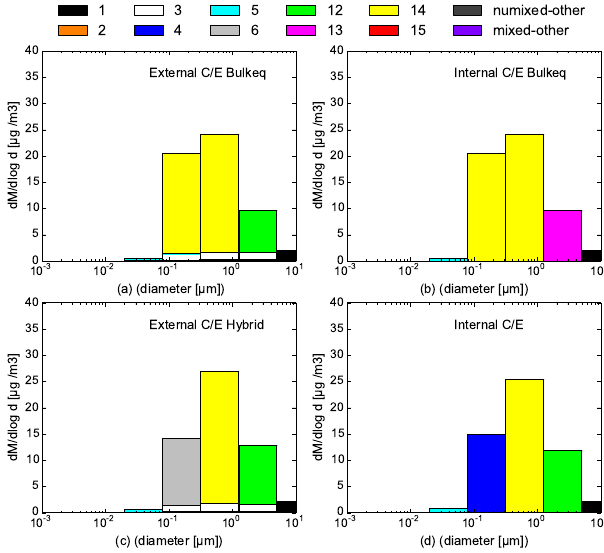
Figure 9. Result mass distributions of externally mixed particles as a function of particle diameter for the different chemical com- positions for four different C / E simulation scenarios: (a) external bulk equilibrium; (b) internal bulk equilibrium; (c) external hybrid method; and (d) internal